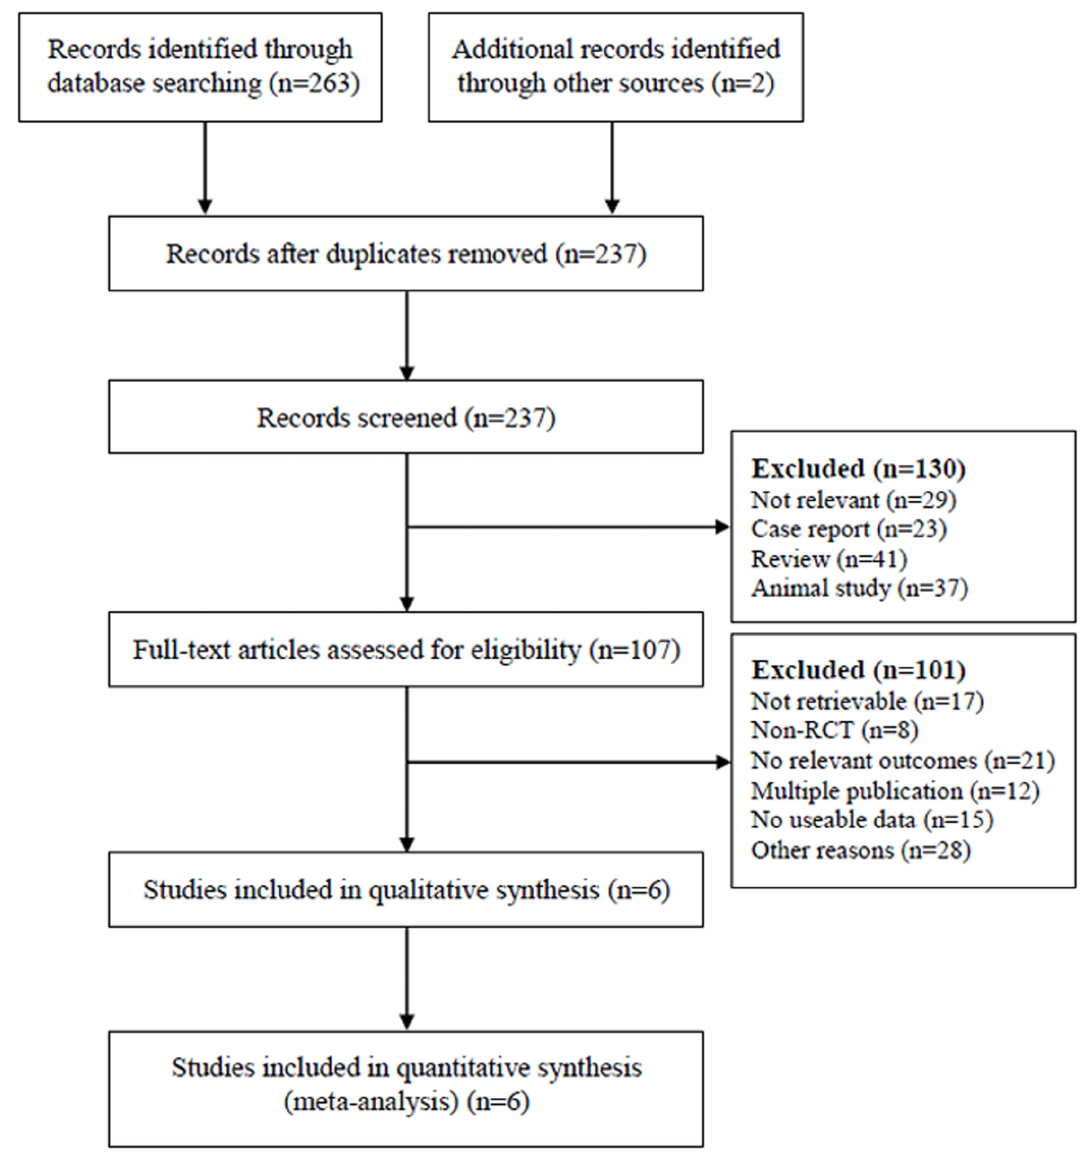
Figure 1. Flow diagram showing the selection process of articles. RCT, randomized controlled trial.